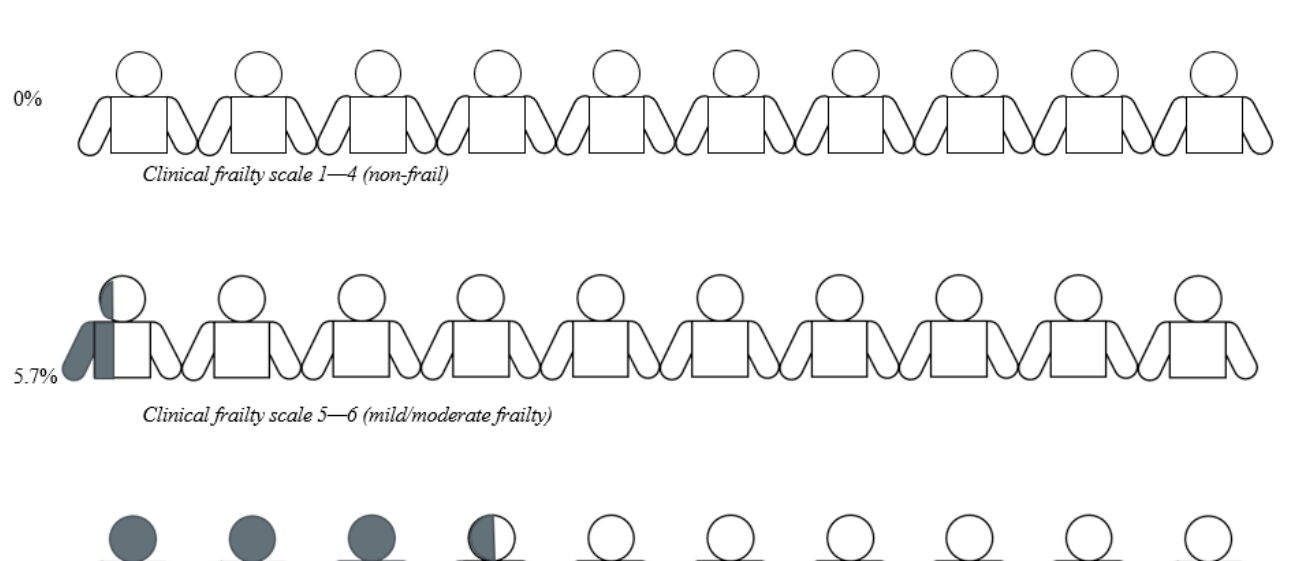
Figure 1. ( A ) Percentages of patients ( n = 499) who had a poor outcome stratified by their frailty status. Patients with poor outcome are shown in grey. ( B ) Percentages of patients ( n = 499) admitted to permanent nursing home care stratified by their frailty status. Patients admitted to permanent nursing home care are shown in grey.